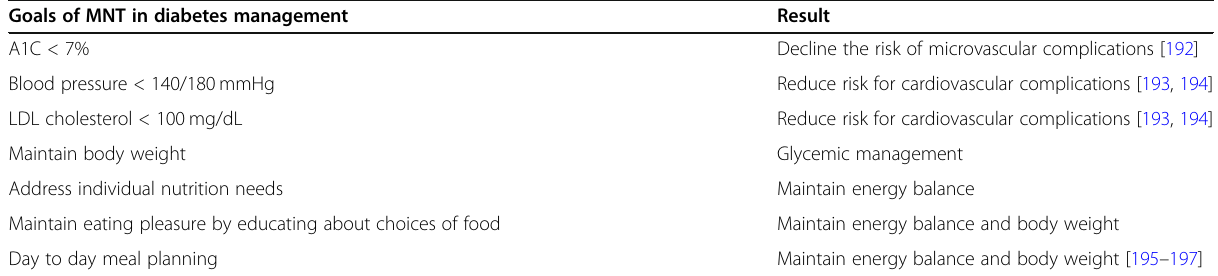
Table 9 Goals of MNT in diabetes management Goals of MNT in diabetes